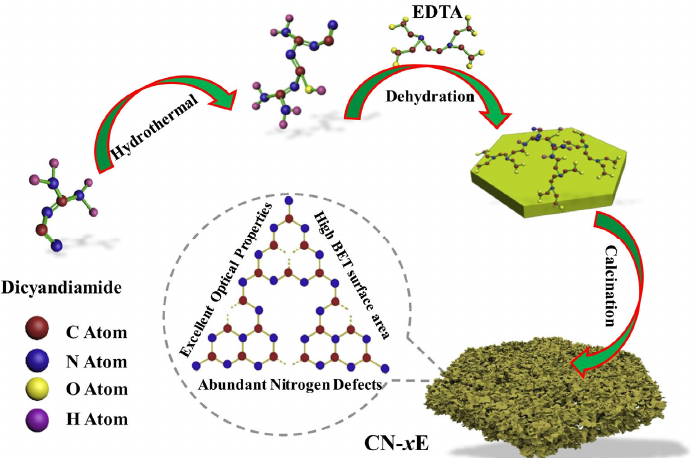
Figure 17. Scheme of the synthesis for multi-hole hexagon of g-C 3 N 4 . Copyrights 2020 Elsevier [146].